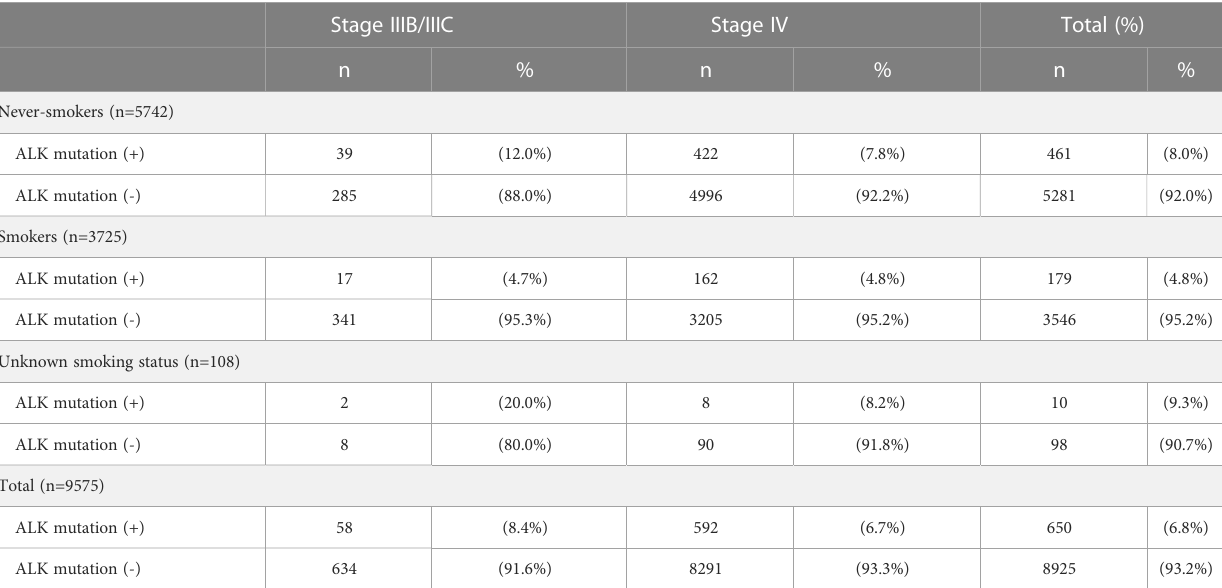
TABLE 1 ALK-positive rates.